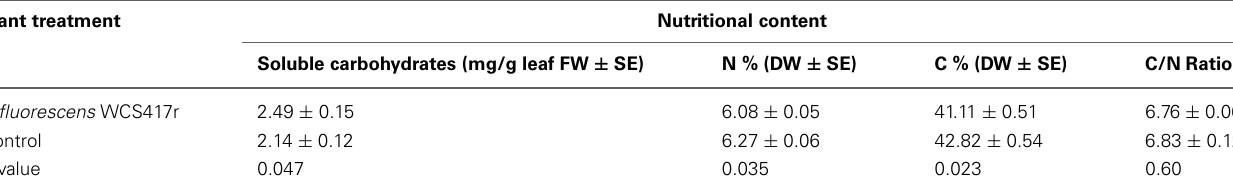
Plant treatment